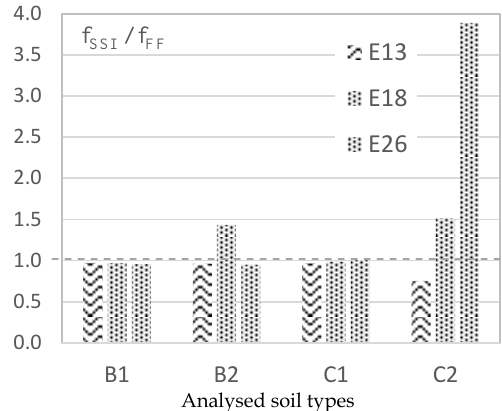
Figure 17. Comparison between the SS and the FF frequencies (visco-nonlinear analyses).